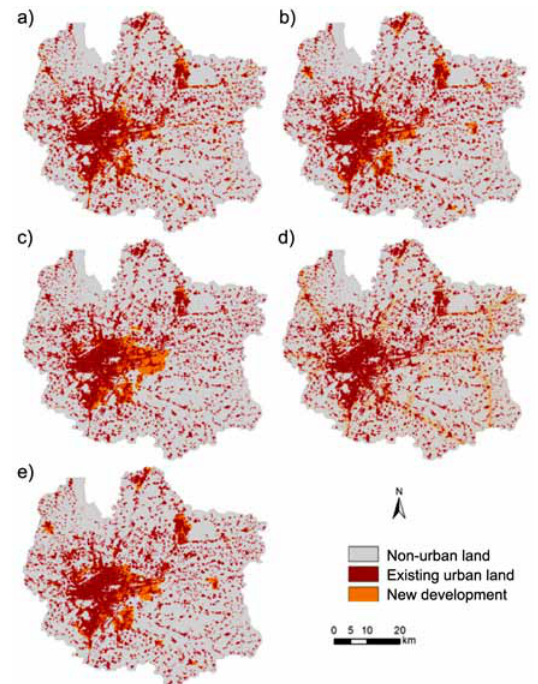
Fig. 10. The alternative urban maps of Xuzhou city for